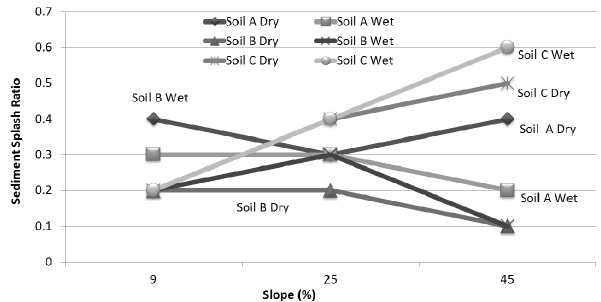
Fig. 4. Sediment splash ratios by soil type and moisture content Figure 4 Sediment splash ratios by soil type and moisture content under different slope steepness under different slope